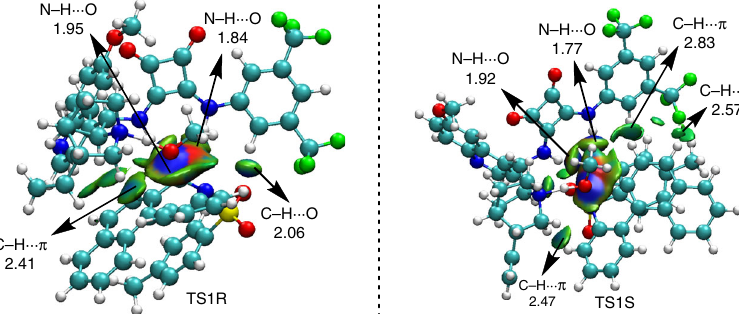
Fig. 4 NCI analysis for stereocontrol of transition states TS1R and TS1S. Blue, green, and red coloration represent strong interaction, weak interaction, and steric hindrance, respectively.